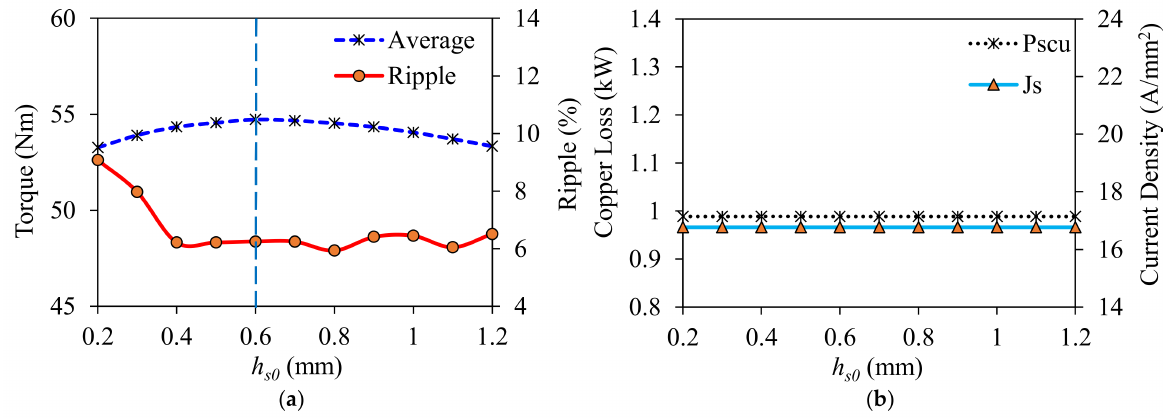
Figure 38. Variation of some key performance characteristics with b s 12 : ( a ) torque and torque ripple and ( b ) stator copper loss and current density.